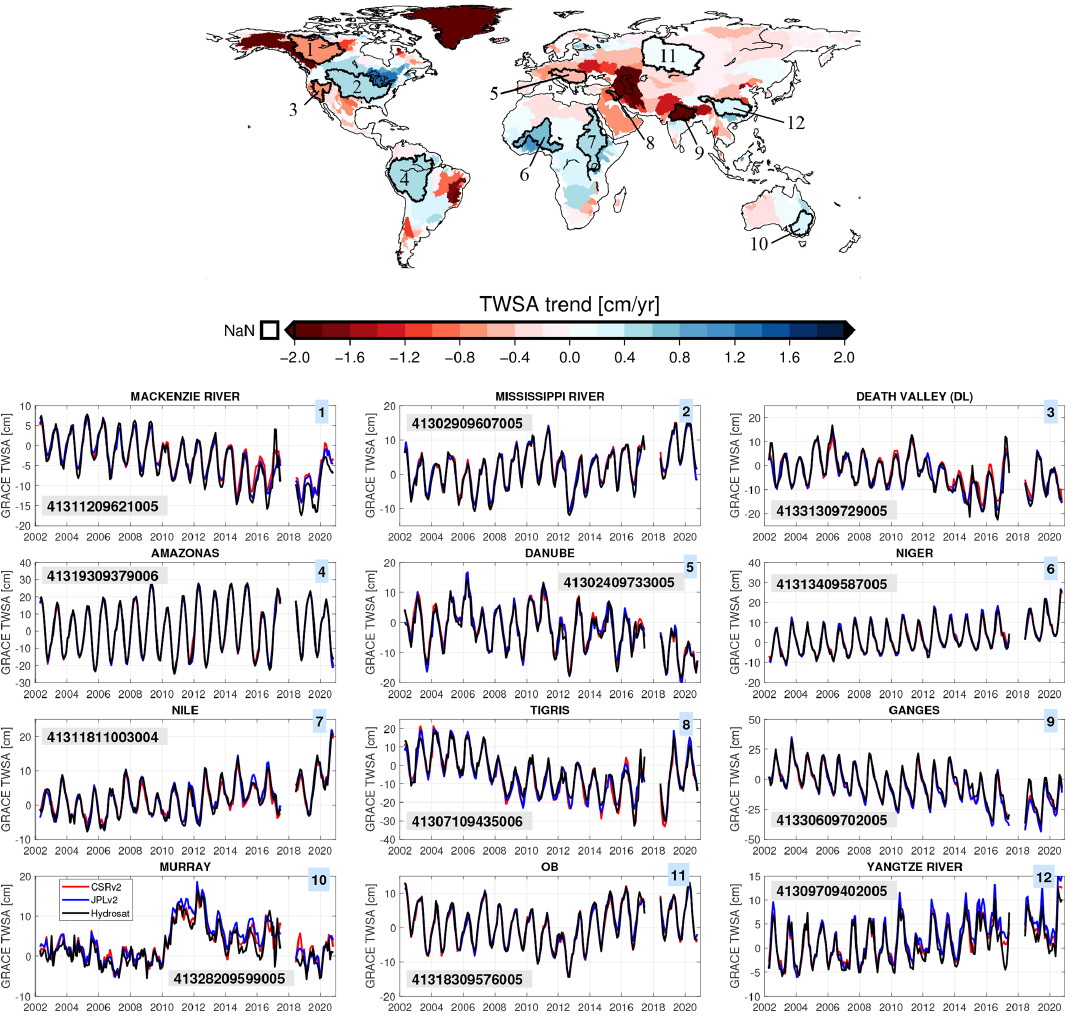
Figure 5. Top: annual trend of TWSA over major global river basins from April 2002 to 2020. Selected basins are numbered on the map. The borders are defined based on the major river basins of the world of the Global Runoff Data Centre (GRDC; https://www.bafg.de/GRDC, last access: 18 May 2022). Bottom: time series of TWSA from GRACE and GRACE-FO for the selected basins, comparing the results from HydroSat, JPLv02 global mascons and CSRv02 global mascons. The corresponding HydroSat number for each basin is provided in the gray